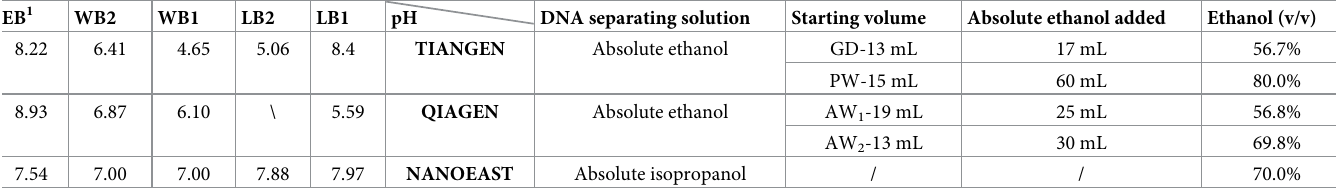
Table 6. pH of the serial buffer solutions and ethanol used in the existing DNA extraction protocols of current